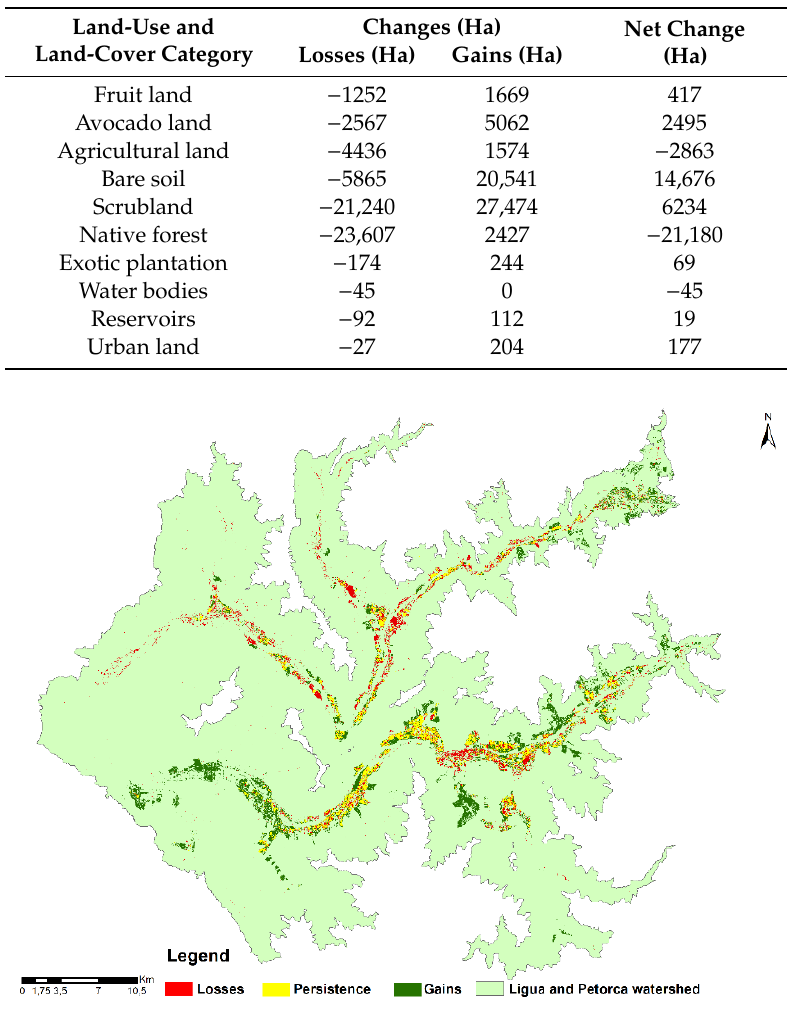
Figure 11. Gains, persistence, and losses of avocado land.